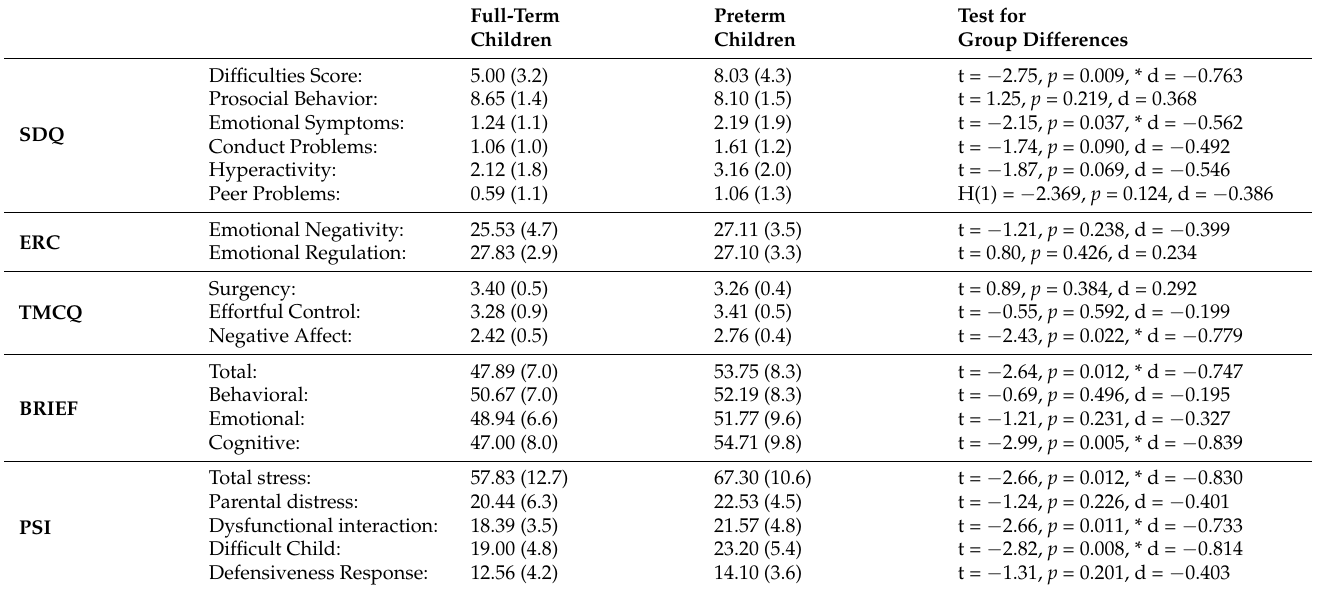
Table 3. Descriptive statistics and analysis for between-group comparisons for parent-reported questionnaires. Statistically significant differences between groups are marked with * ( p < 0.05).